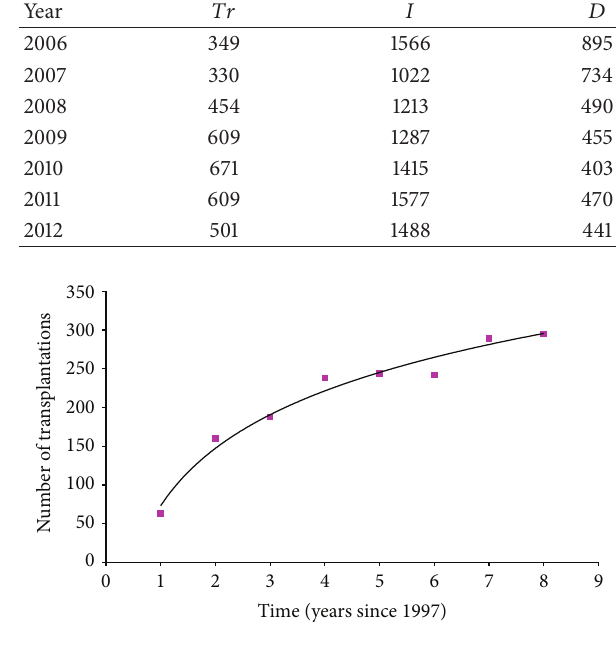
Figure 1: Fitted curve by the method of maximum likelihood to the data from Table 1 to project the number of transplantations, 𝑇𝑟 , in the future (before